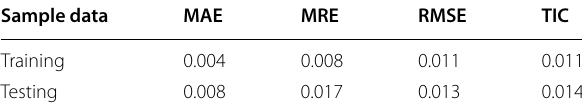
Table 3 Prediction error results of GRA–SVR